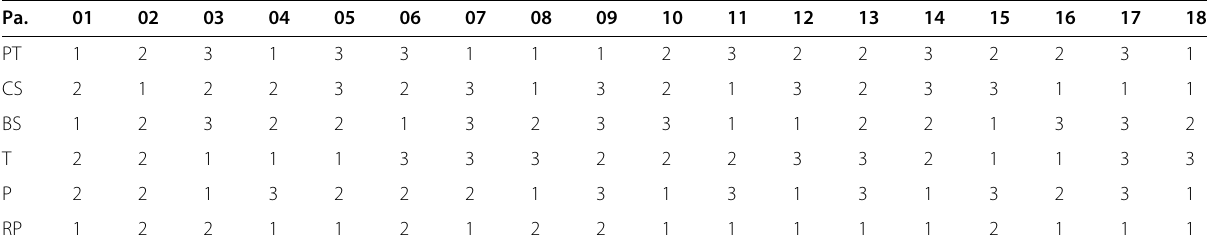
Package combinations with attribute levels as given in Table 1.; Pa.= Package, PT= Public Transport, CS= Car Sharing, BS= Bike Sharing, T= Taxi, P= Price, RP= Route Planner